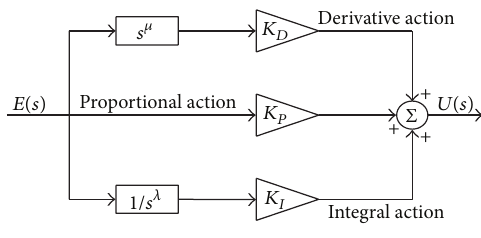
Figure 2: FOPID controller structure.